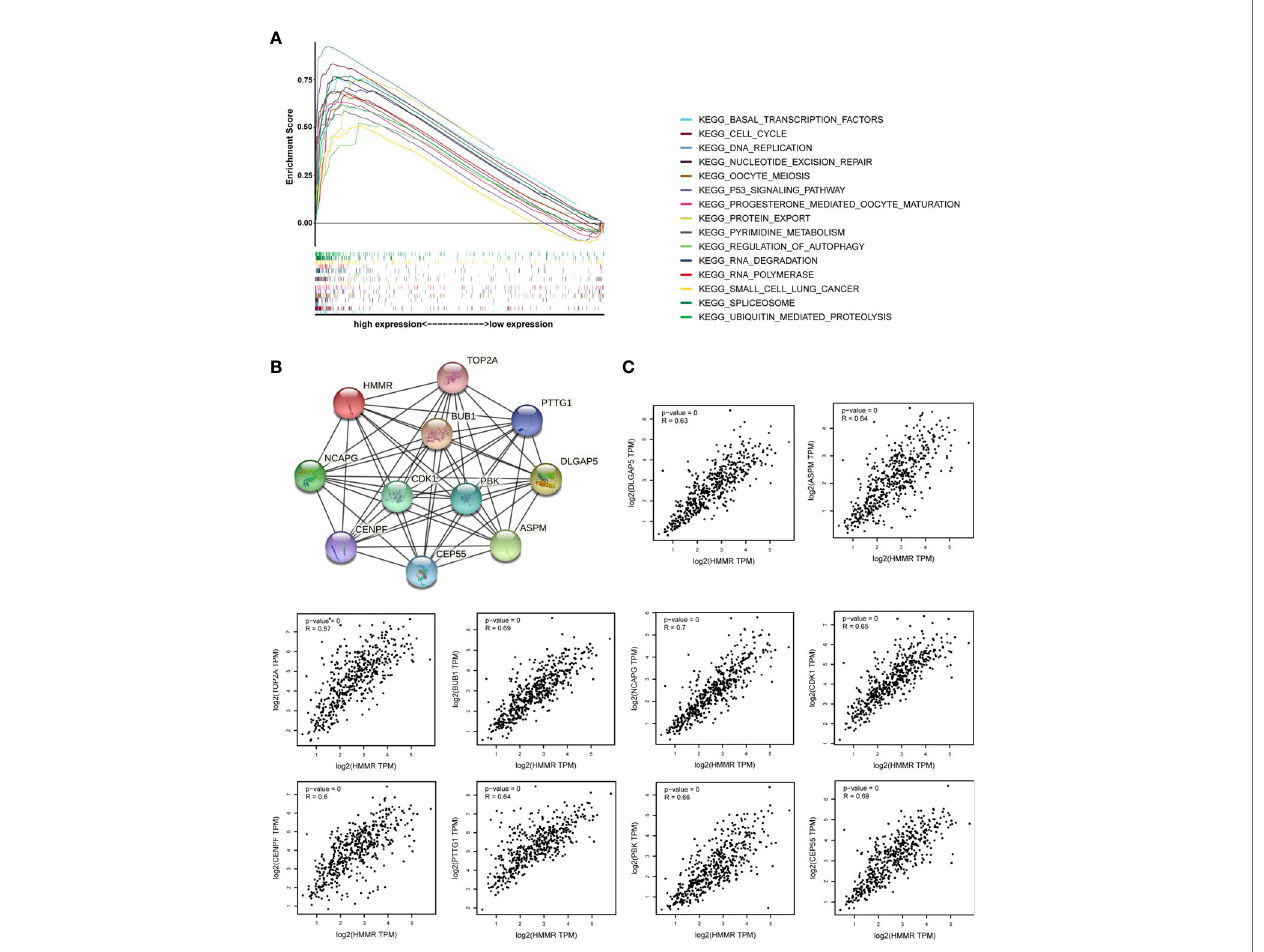
FIGURE 5 | The investigation on the potential mechanism of HMMR in promoting LUAD progression. (A) The merged enrichment plot including enrichment scores and gene sets. (B) The PPI network plot for HMMR including 10 predicted genes co-expressed with HMMR . (C) Correlation between HMMR and 10 genes co-expressed with HMMR ( TOP2A , PTTG1 , DLGAP5 , ASPM , CEP55 , CENPF , NCAPG , BUB1 , PBK , and CDK1 ).